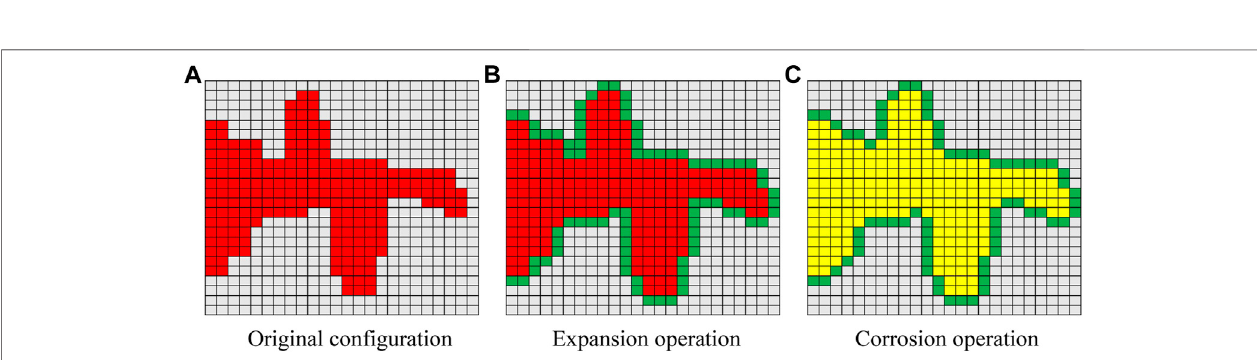
FIGURE 6 | Schematic diagram of closed operation (FISHMEMORY, 2016). (A) Original con fi guration, (B) expansion operation, and (C) corrosion operation.